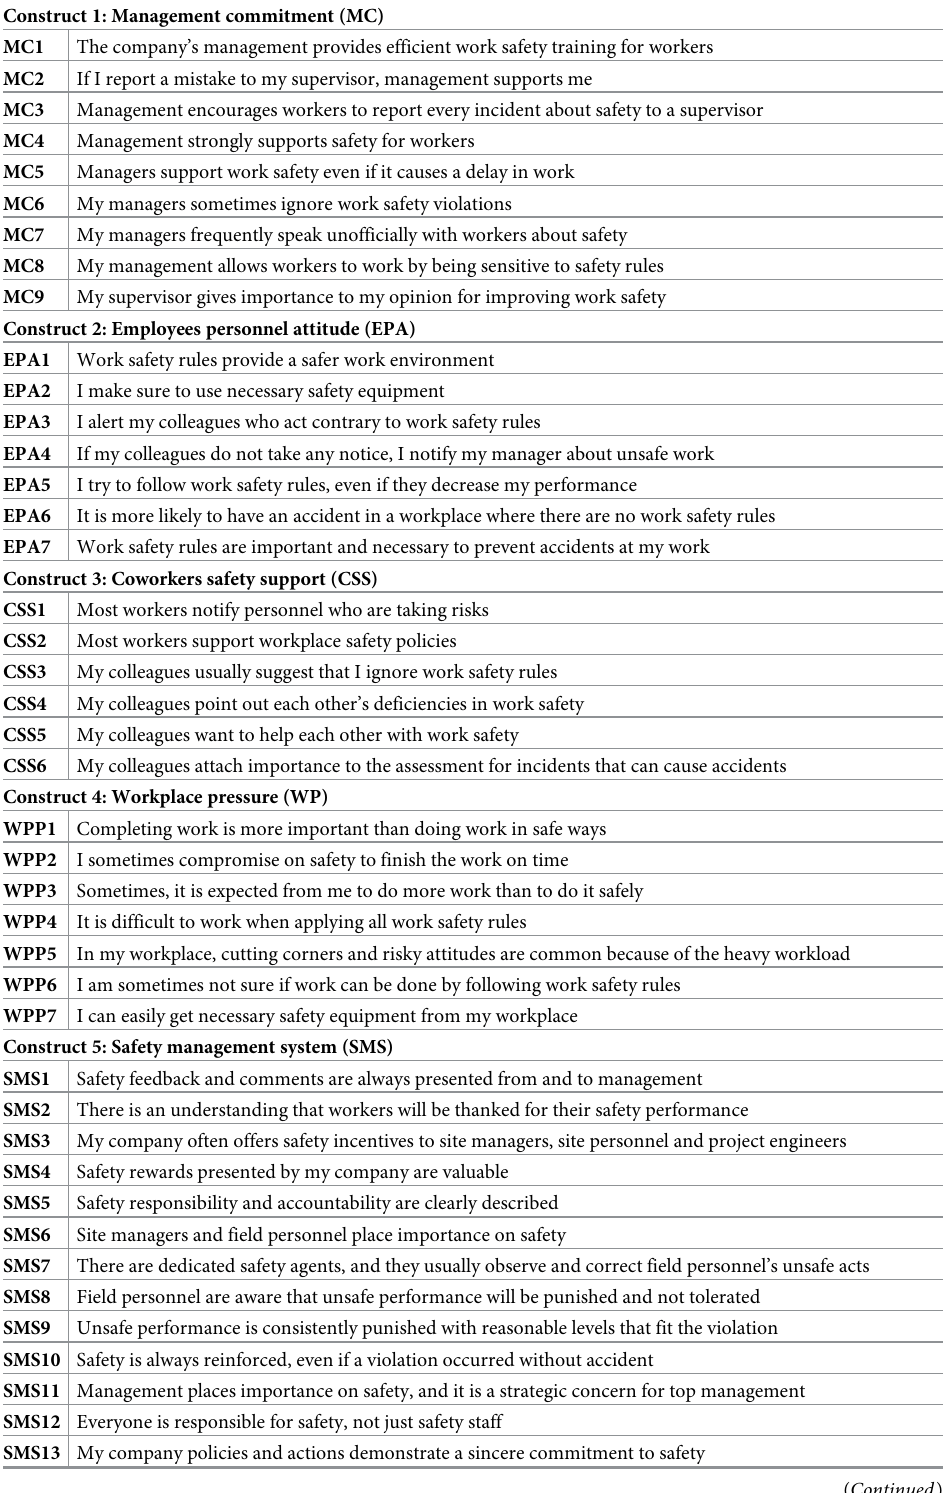
Table 1. Model constructs and their corresponding item